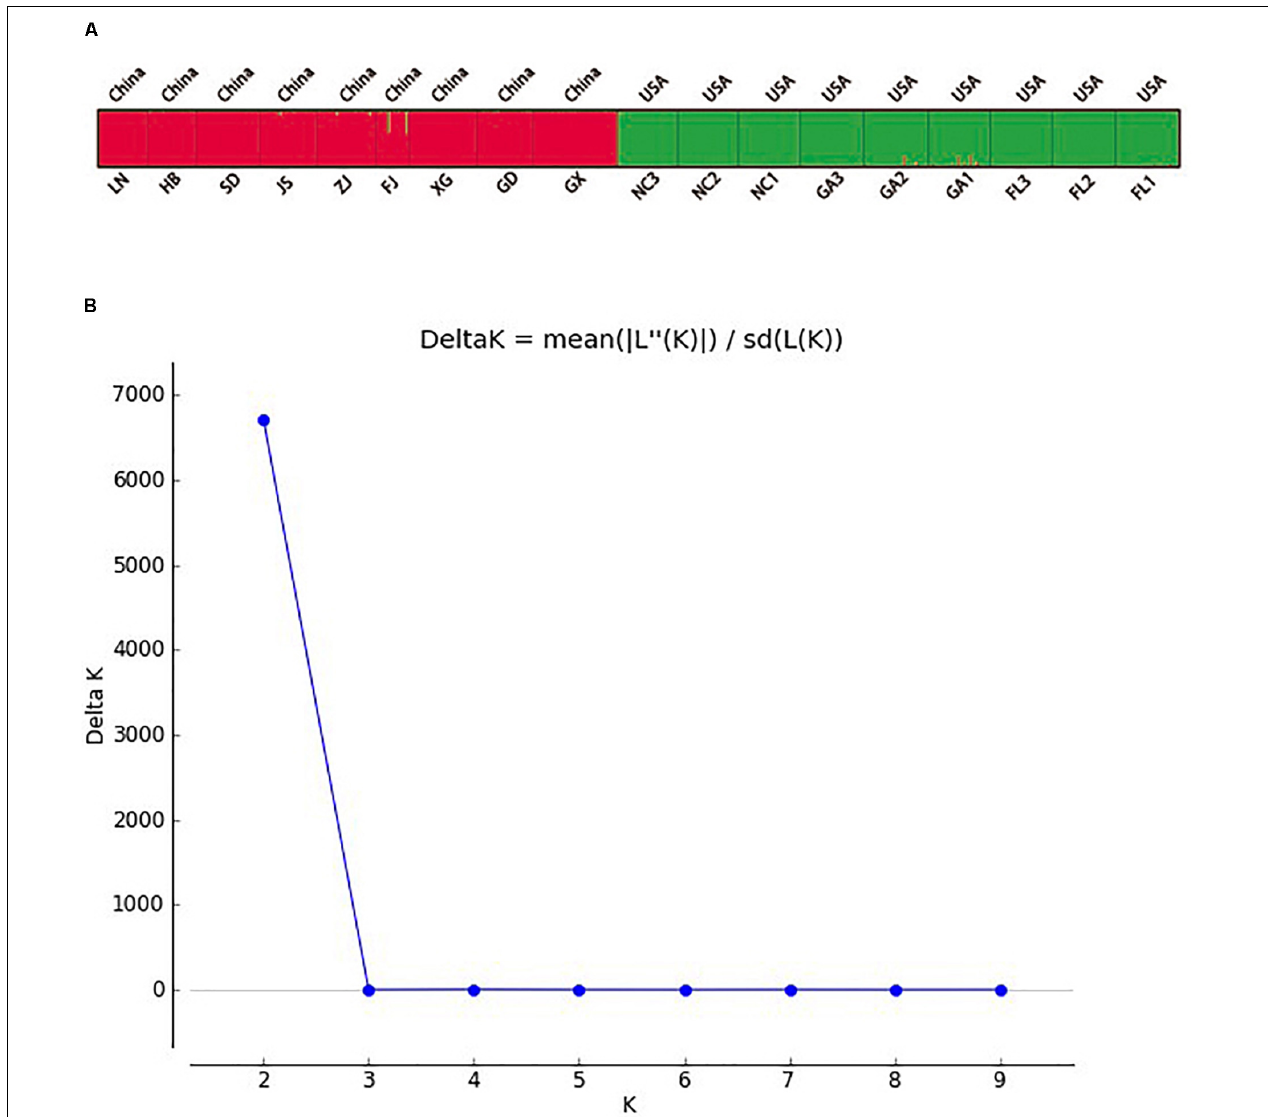
FIGURE 4 | The population genetic structure of Spartina alterniflora across invasive and native ranges (A) and the Delta K analysis (B)